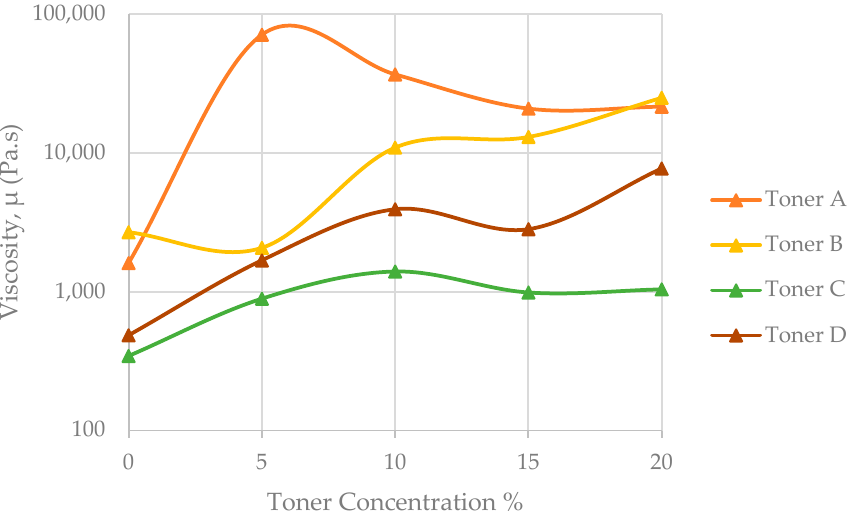
Figure 6. The influence of % toner concentration on viscosity ( µ ) for waste toners A, B, C, and D, measured at 1.59 Hz and 60 °C.